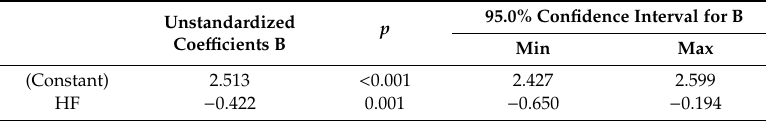
Table 4. Multivariate analysis of peak plasma